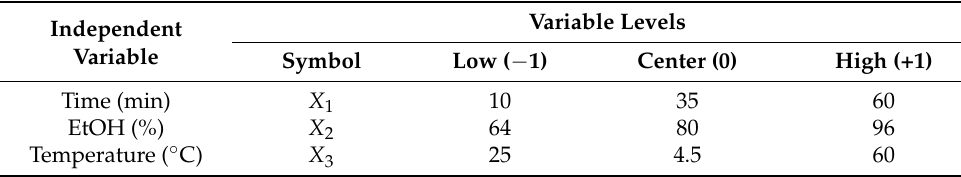
Table 1. Independent variables for the experimental